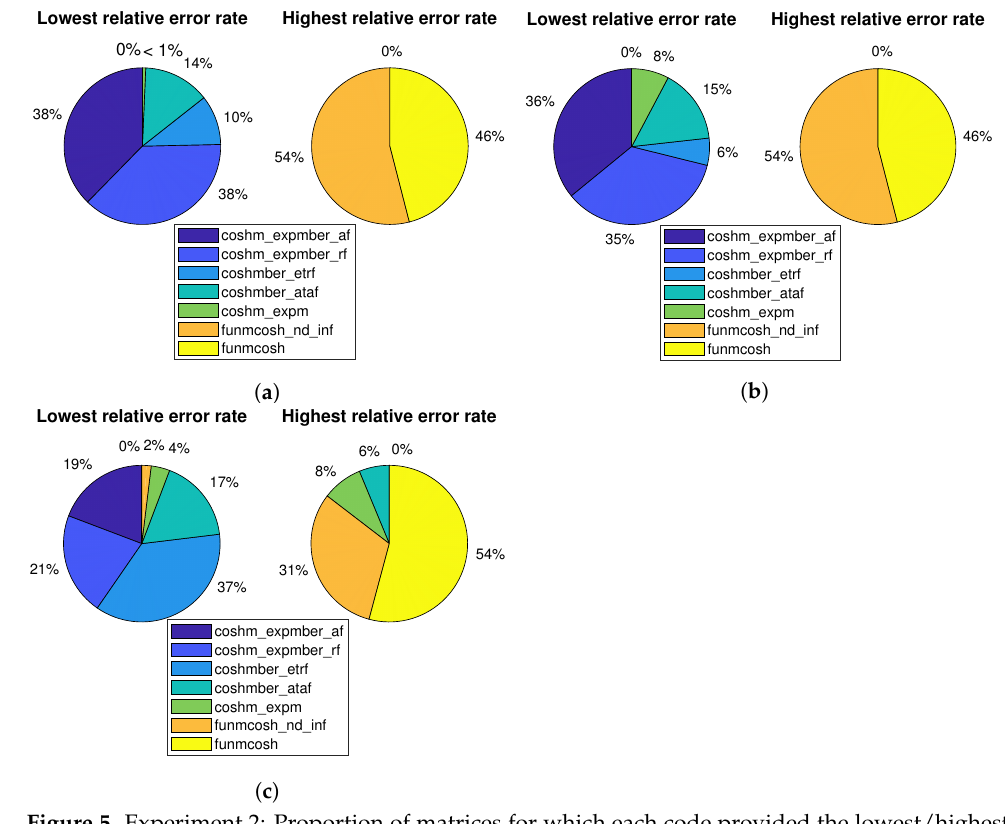
Figure 5. Experiment 2: Proportion of matrices for which each code provided the lowest/highest error for matrix sets 1 ( a ), 2 ( b ) and 3 ( c ).